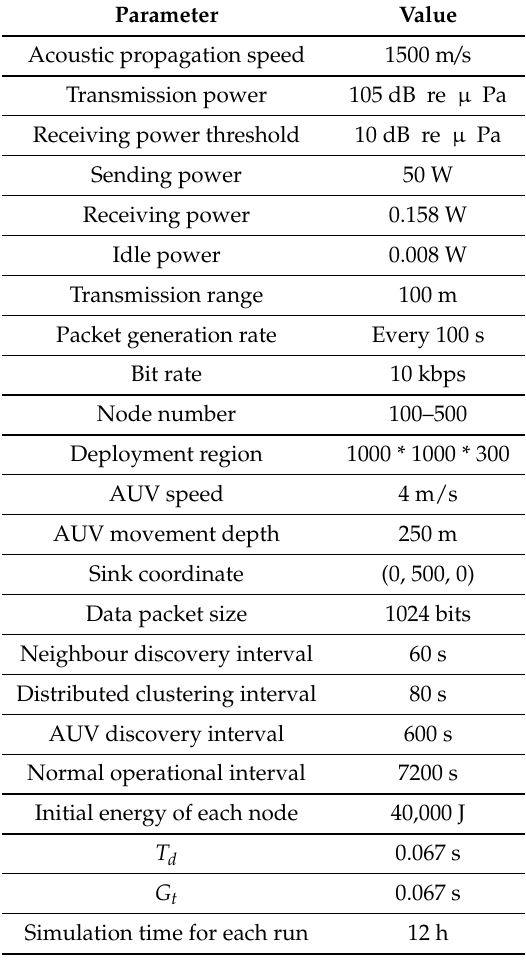
Table 1. Simulation